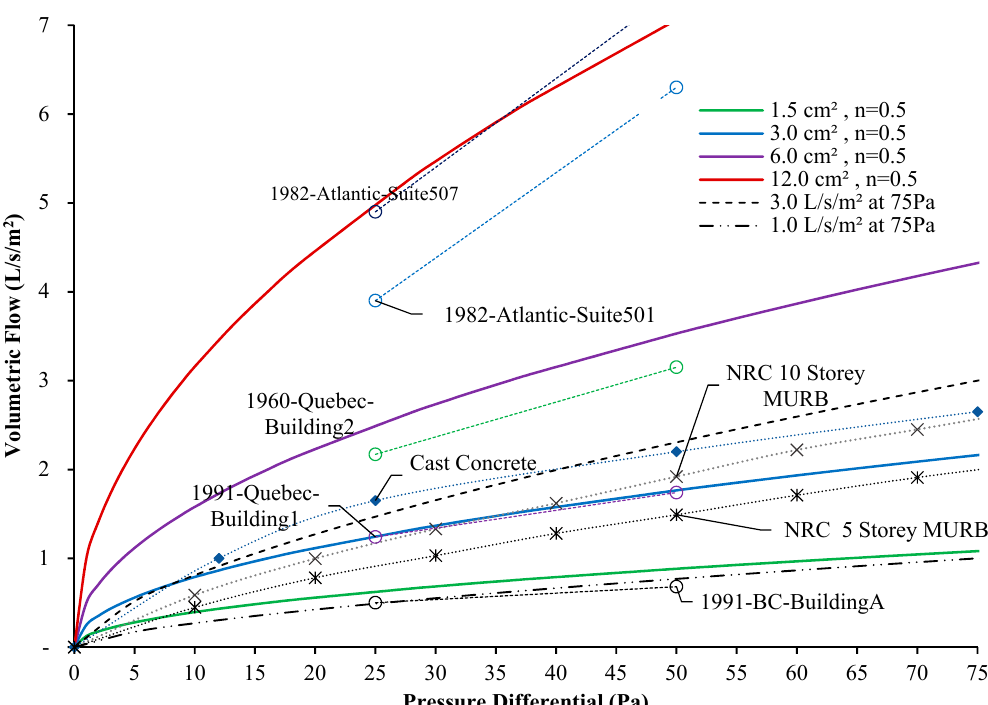
Figure 3. Airflow through building envelopes under pressure differential for specified leakage areas, air leakage standards, and field measurements.